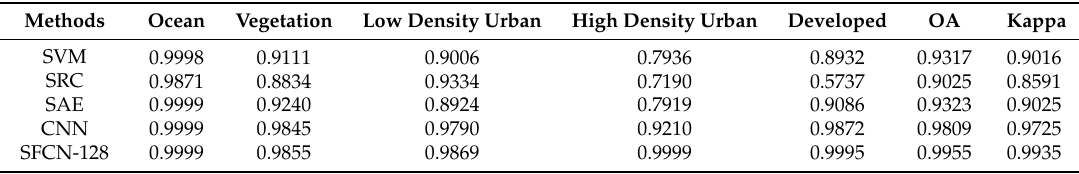
Table 4. Classification results of San Francisco with different